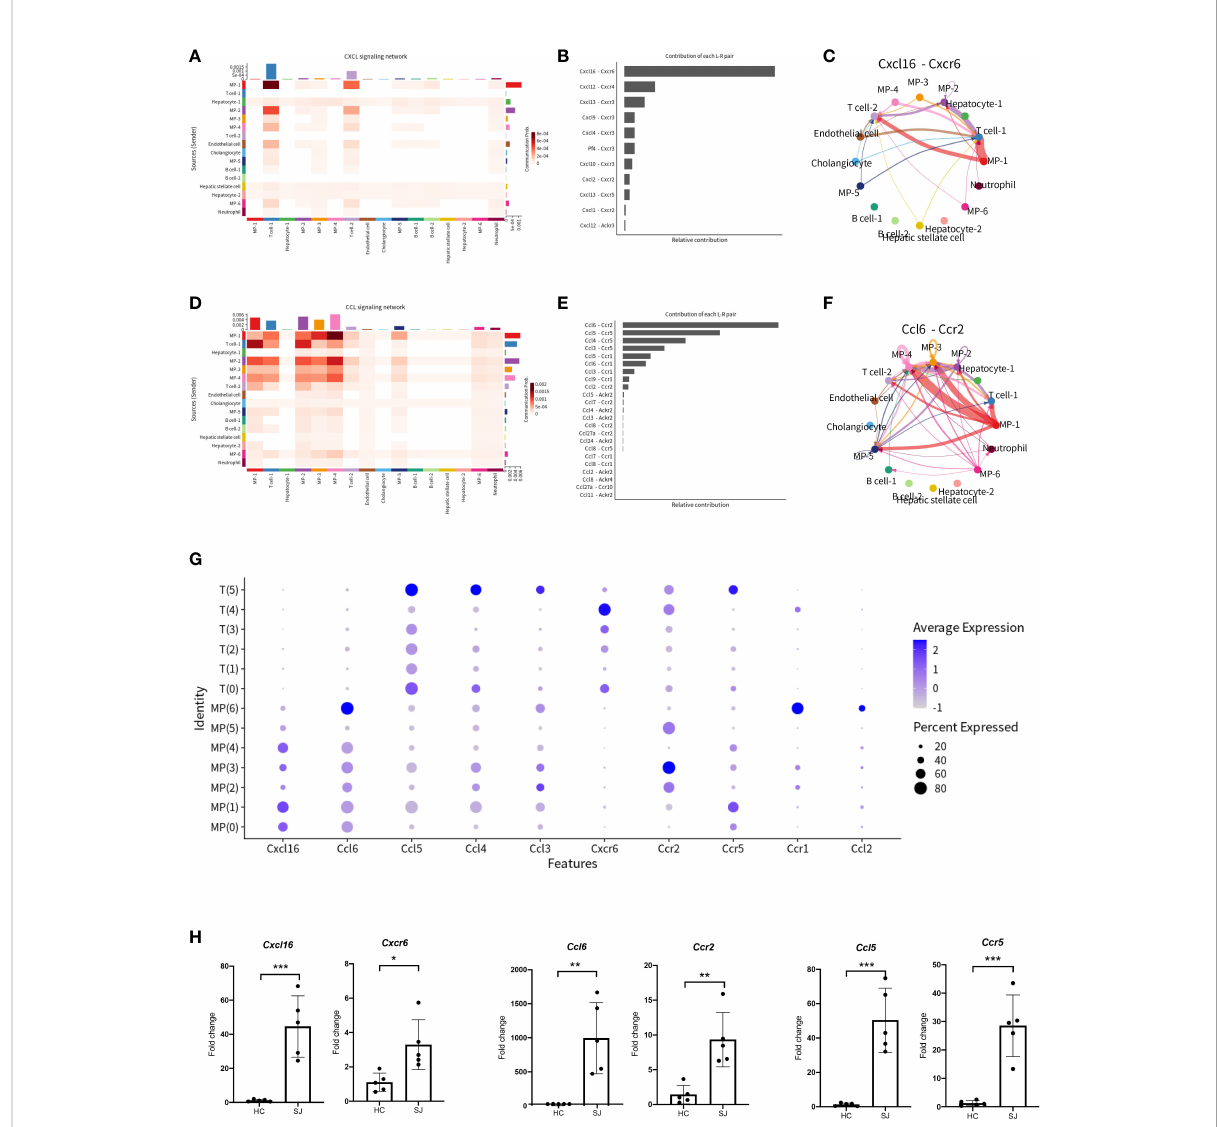
FIGURE 5 CXCL and CCL signaling pathway network in fi brotic liver of schistosomiasis japonica. (A) Heatmaps of the differential number of interactions between different cell clusters in CXCL signaling network. (B) Relative contribution of each ligand-receptor pair to CXCL signaling network. (C) Circle plots displaying the Cxcl16-Cxcr6 network between different cell clusters. (D) Heatmaps of the differential number of interactions between different cell clusters in CCL signaling network. (E) Relative contribution of each ligand-receptor pair to CCL signaling network. (F) Circle plots displaying the Ccl6- Ccr2 network between different cell clusters. (G) Bubble plots of different chemokines and their receptor in MPs and T cells. (H) The qPCR of Cxcl16, Cxcr6, Ccl6, Ccr2, Ccl5 and Ccr5 in schistosome- fi brotic livers(n=5) and normal livers(n=5). The signi fi cance level was tested by unpaired t test and the data are shown as the mean ± s.d value (*p < 0.05; **p < 0.01; ***p < 0.001; ****p <